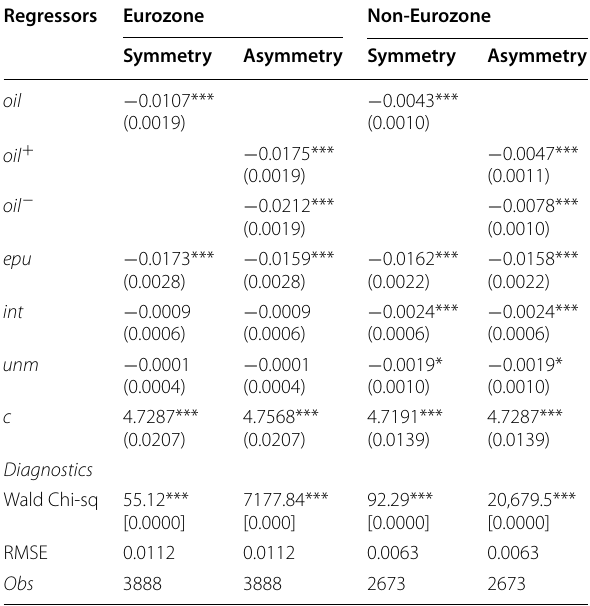
Values in brackets are standard errors, while those in parentheses are probabilities. *** and * indicate significance at 1% and 10% critical levels, respectively